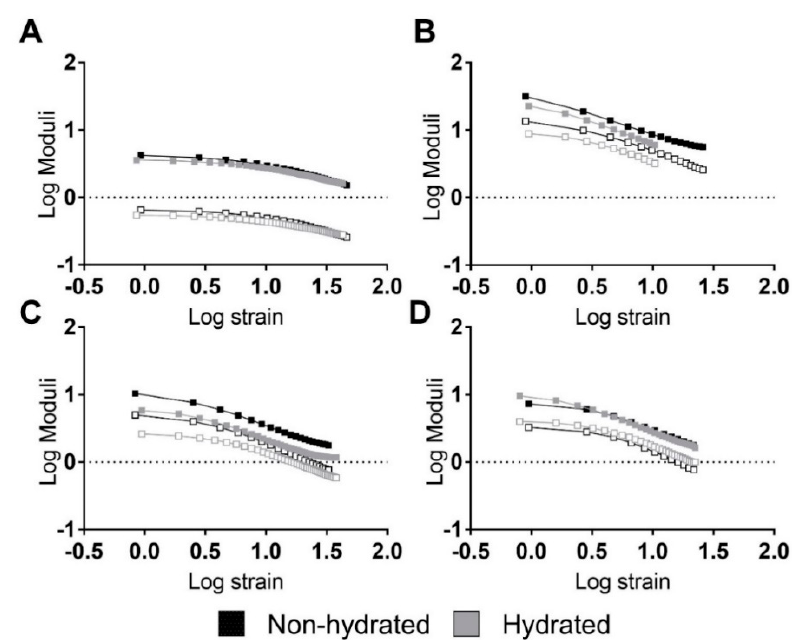
Figure 3. Strain sweeps of the studied PUs revealing strong relations between moduli and strain. Representative performances of hydrated and non-hydrated PUs: ( A ) 5–90–5, ( B ) 45–45–10, ( C ) 46.3–46.3–7.5, and ( D ) 47.5–47.5–5. Filled squares represent the storage modulus while non-filled squares represent the loss modulus.